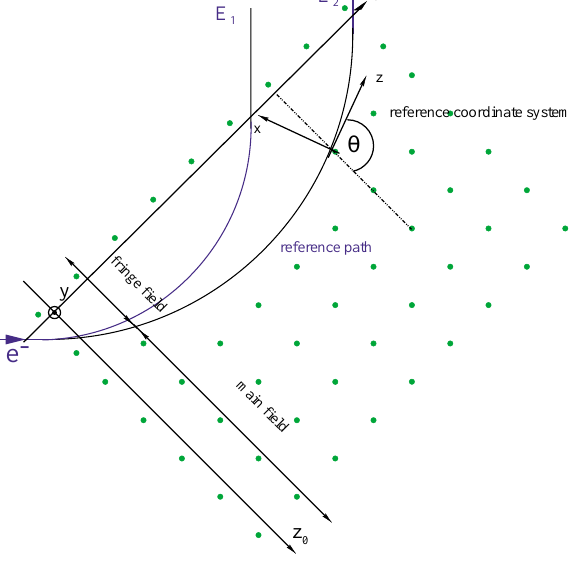
FIG. 2. (Color) Fringe field and main field regions of a 90 ± HDSM bending